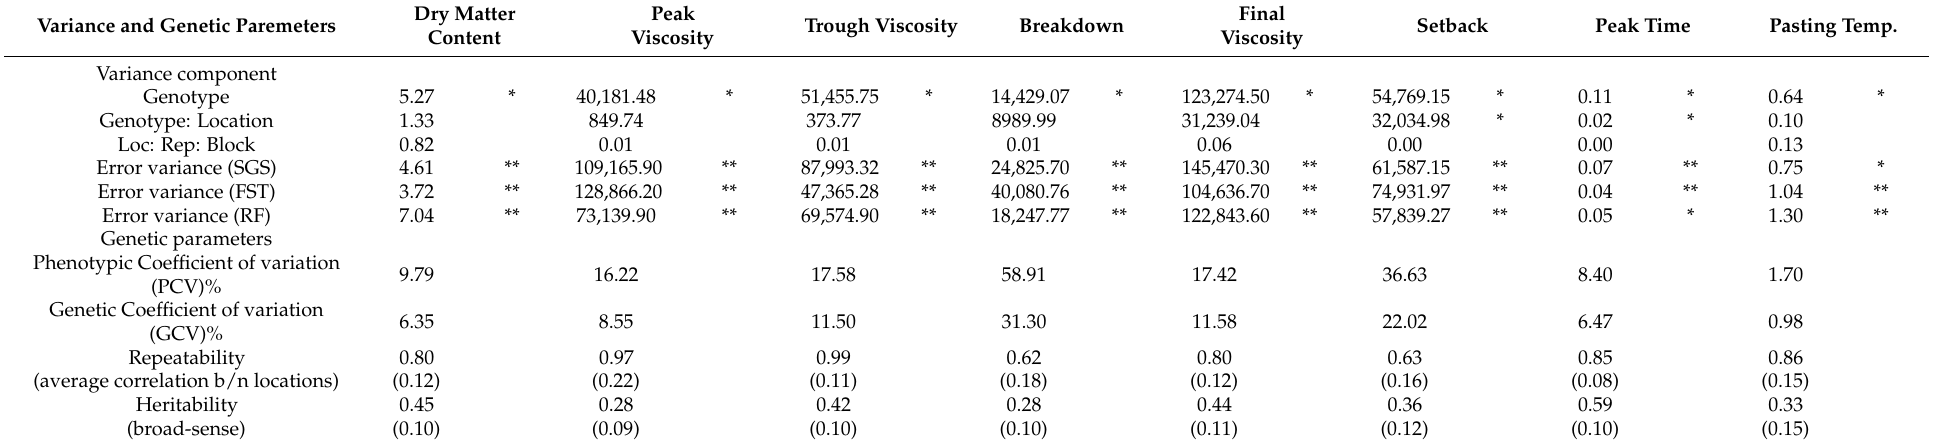
Table 2. Variation due to random effect and genetic parameter estimates of tuber dry matter content and starch pasting properties in twenty Dioscorea rotundata genotypes grown in three different locations in Nigeria.